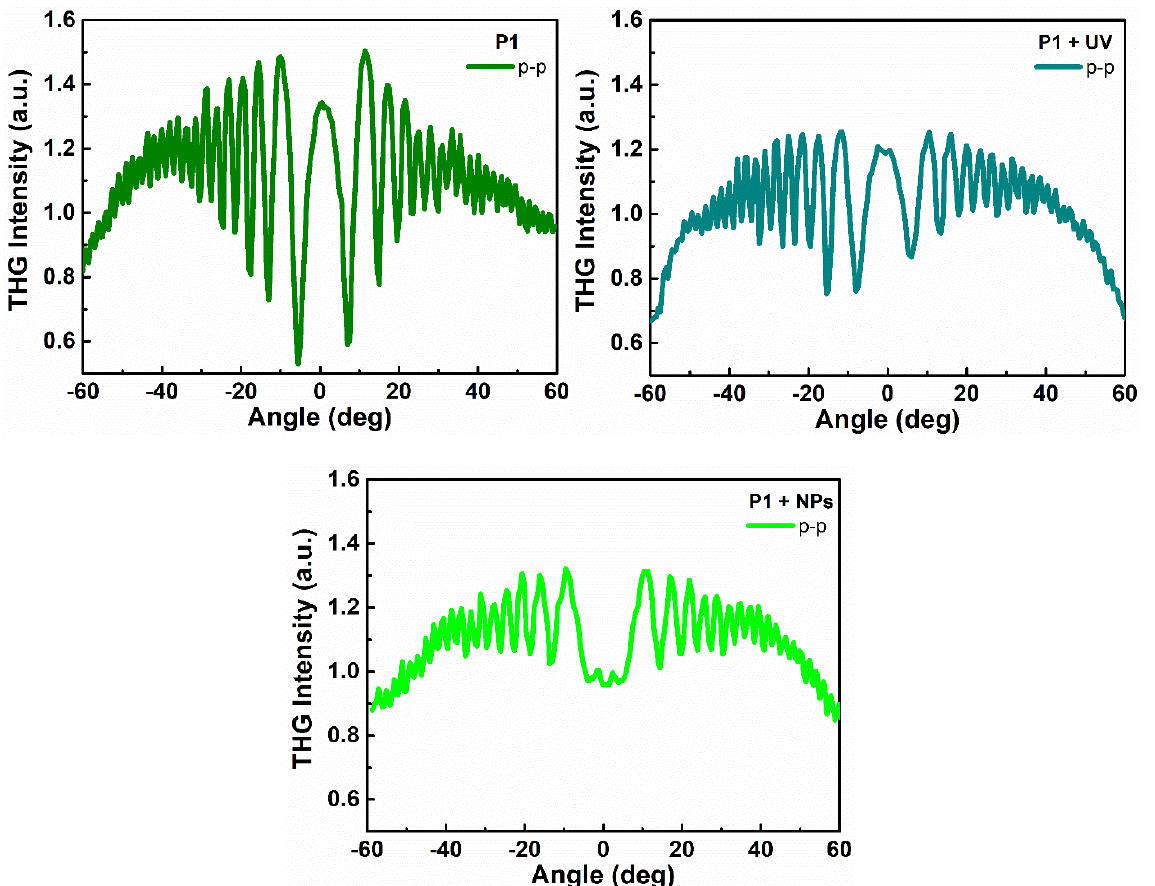
Figure 7. Third harmonic generation intensities as a function of rotation angle of polymer P1 after ultraviolet-irradiation (UV) and with ZnO nanoparticles (NPs) in a p-polarized laser beam.